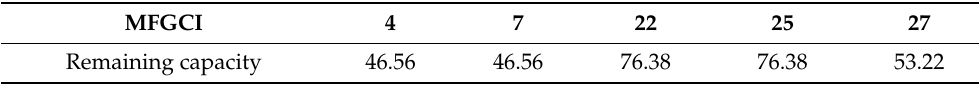
Table 10. Total remaining capacity and maximum and minimum capacity required for harmonic mitigation (kW). Table 9. Remaining capacity of MFGCI at 16:00 (kW).